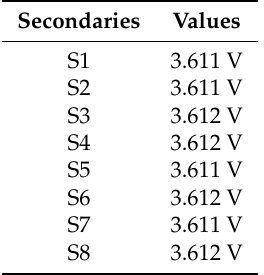
Table 1. Secondary voltages at no-load.